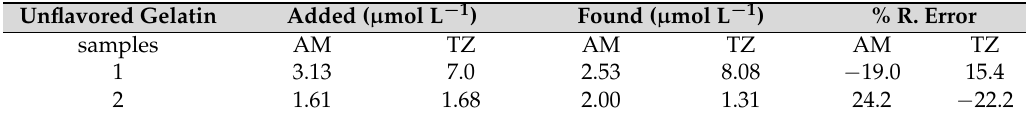
Figure 5. ( A ) Calibration curves of tap water spiked with AM and TZ (1.0 µmol L −1 ); ( B ) AdSV of different dyes: AM and TZ; SY and TZ; and AR (0.5 µmol L −1 ). Conditions: pH 3.2 (0.01 mol L −1 phosphate buffer), E ads 0.00 V, t ads 30 s. Table 2. Determination of AM and TZ in commercial unflavored gelatin.